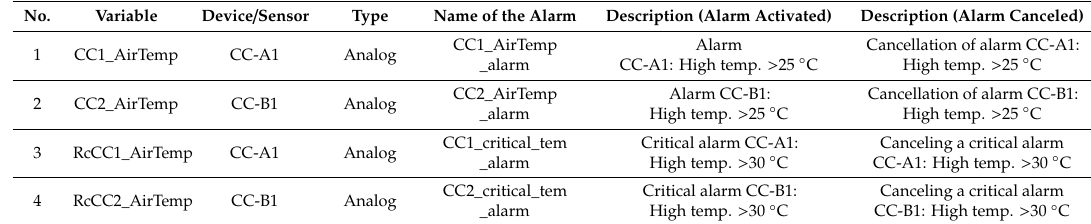
Table 6. Activation alarm area for increased temperature in cooling devices CC1 and CC2.